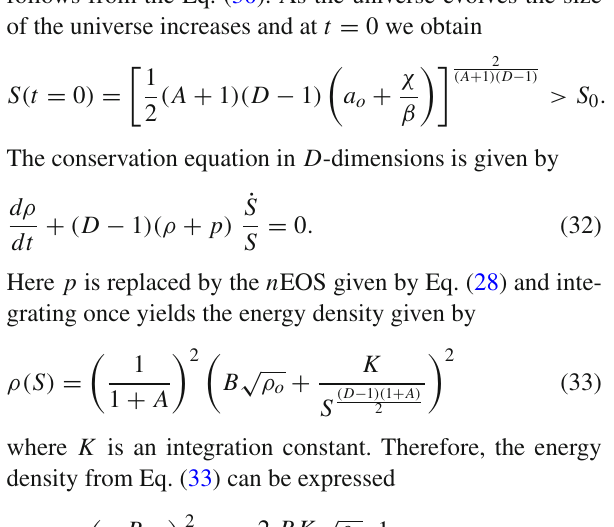
pressure p = p 1 + p 2 + p 3 with the barotropic equa- tion: p i = ω i ρ i , where i = 1 , 2 , 3 and identified